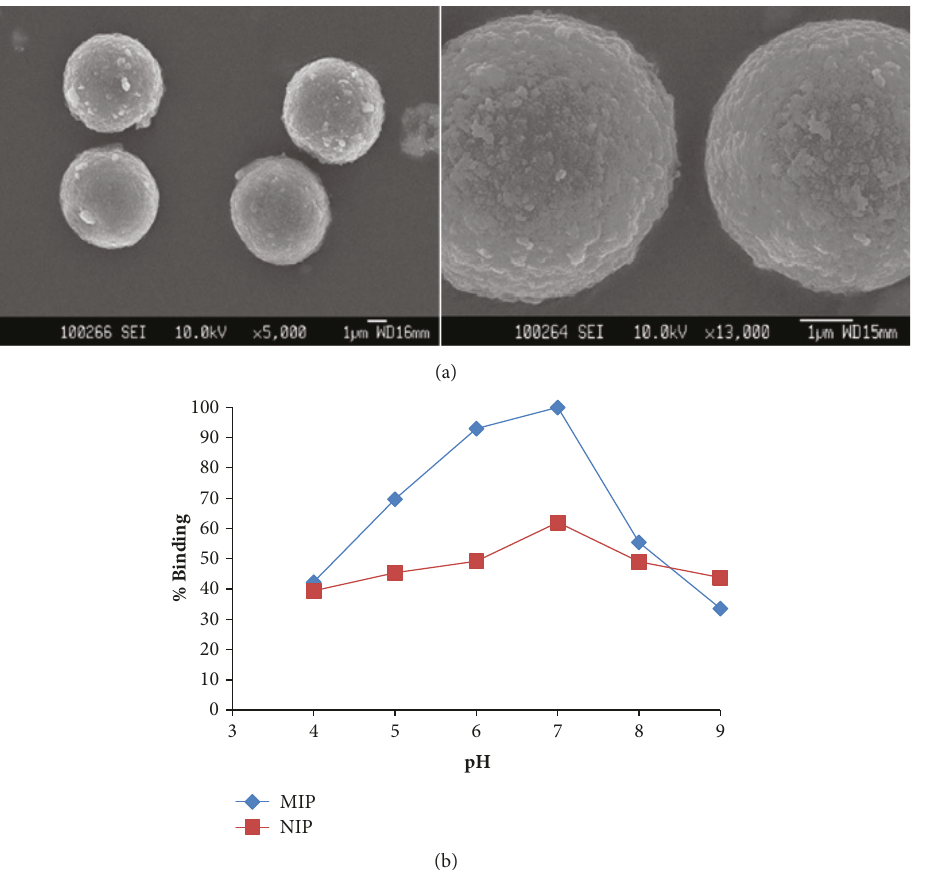
Figure 3: (a) SEM images of th e myoglobin imprinted microspheres. (b) The pH effect on myoglobin binding [C Mb : 0,5 mgmL −1 , m polymer : 20mg, t: